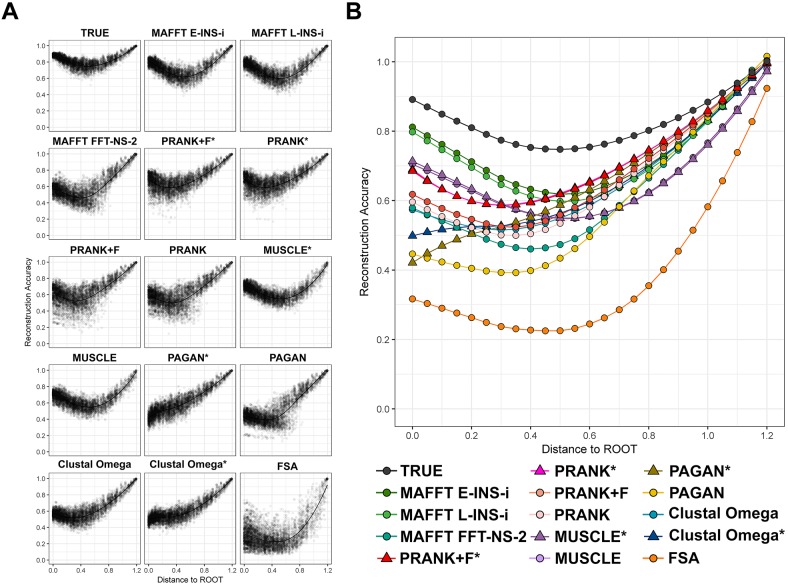
Reconstruction accuracy by distance to root. Reconstruction accuracy at different distances from the root using simulation parameters of 64 taxa, tree height 1.2, sampling fraction 0.01 and indel rate 0.05. (A) Scatter plots of accuracies for each MSA. (B) Combined chart showing the locally weighted scatterplot smoothing (LOESS) of average reconstruction accuracy by distance to root for each MSA tool.